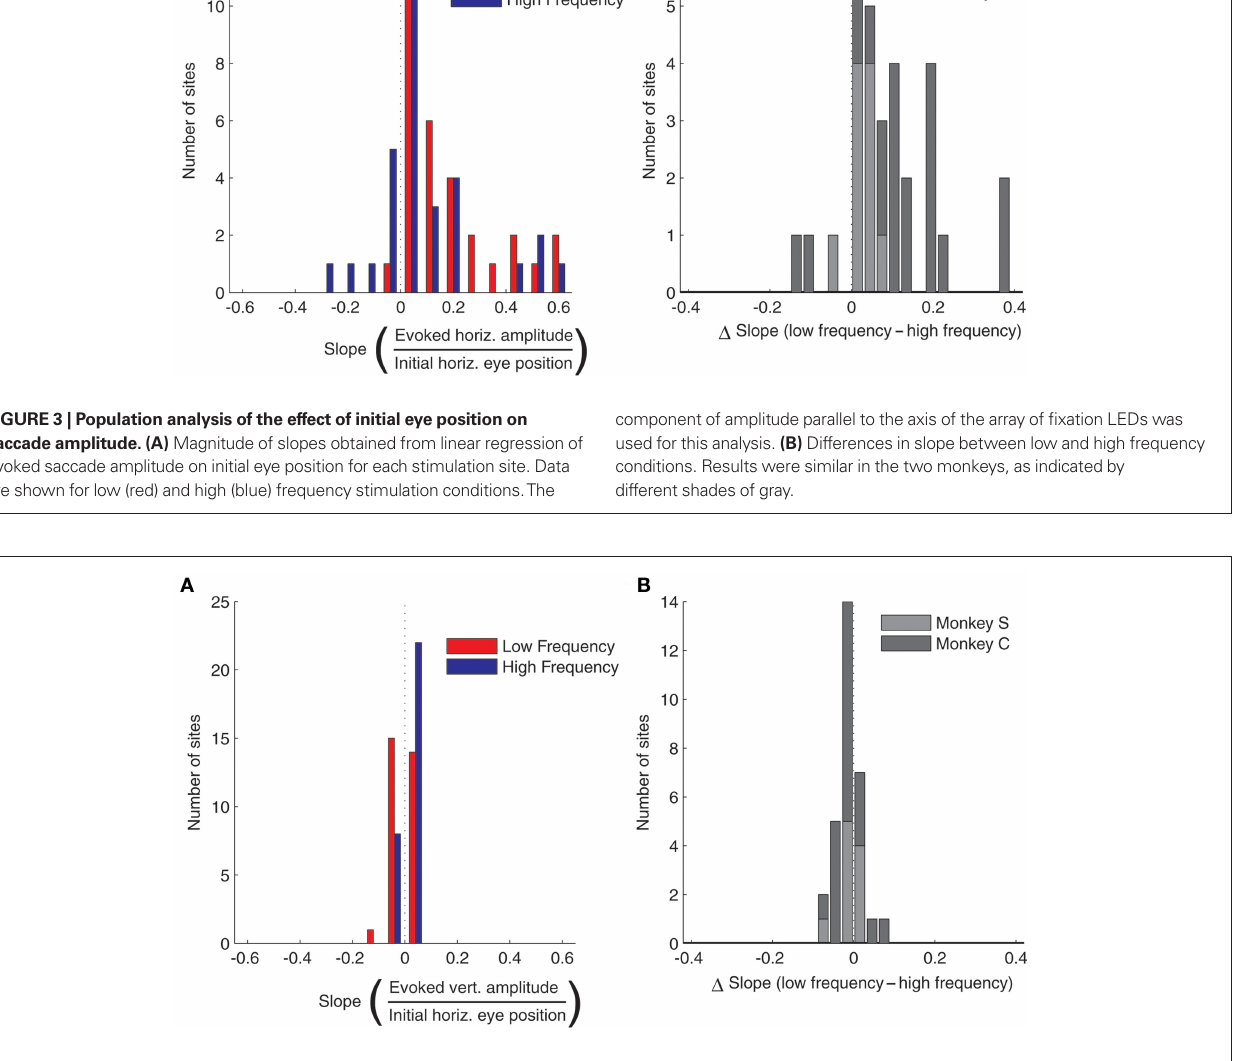
FIgure 4 | Population analysis of the effect of horizontal initial eye position on vertical saccade amplitude. (A) Magnitude of slopes obtained from linear regression of vertical saccade amplitude vs. horizontal initial eye position for each stimulation site. Data are shown for low (red) and high (blue)